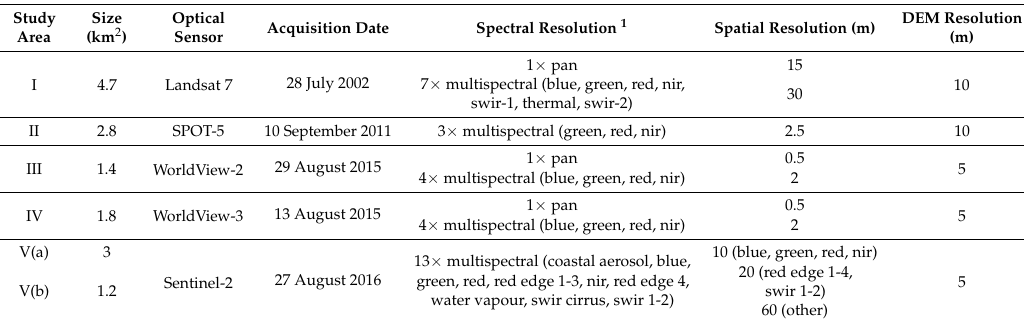
Table 1. Selected database for each study